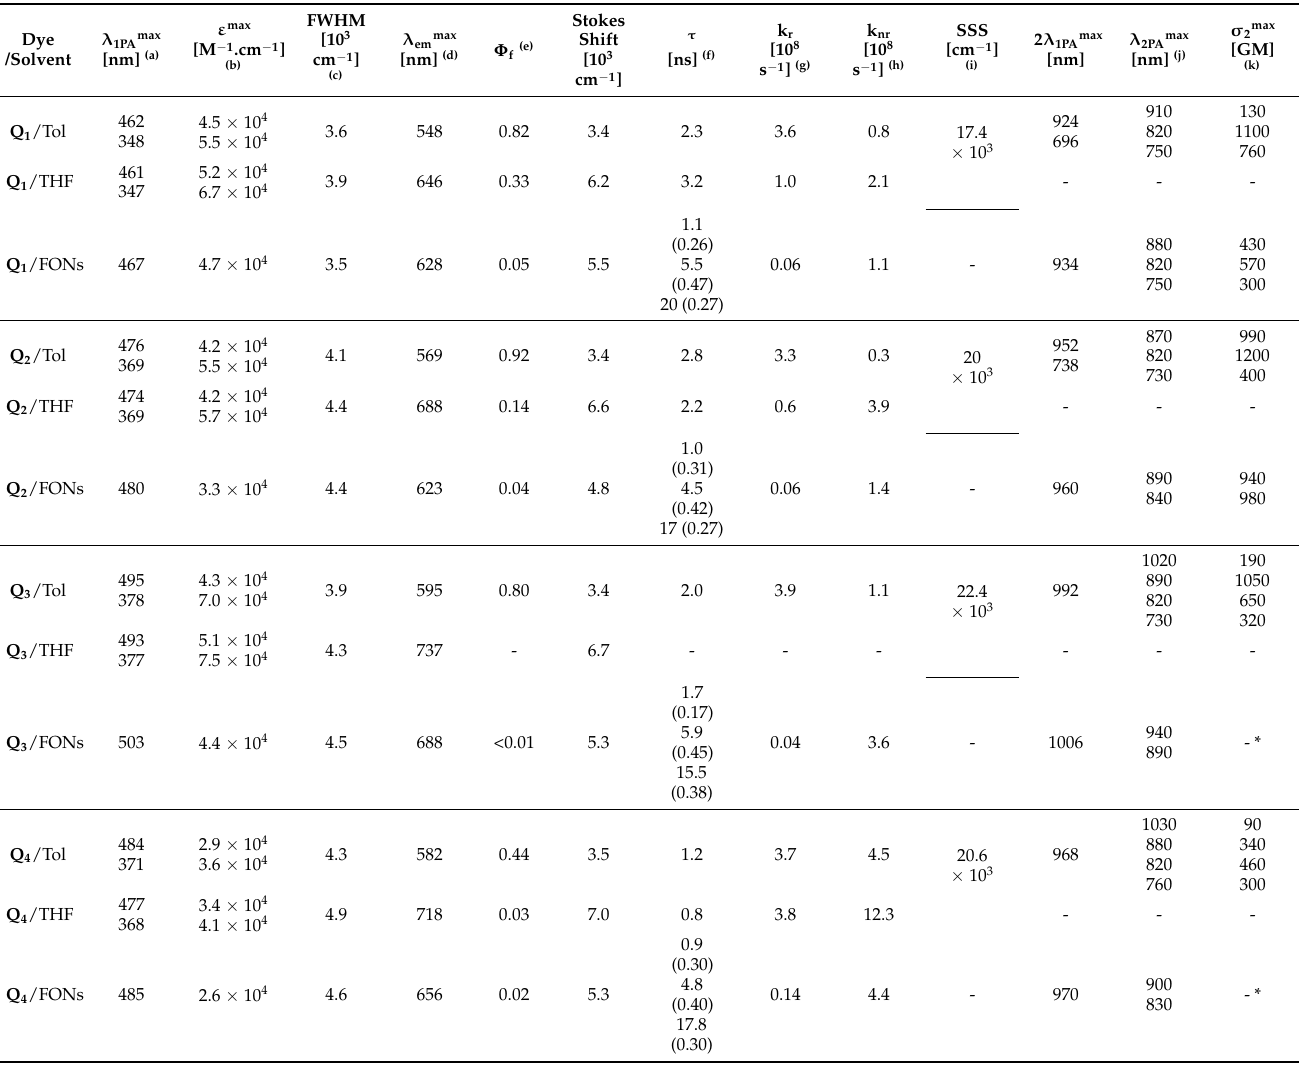
Table 1. 1P and 2P photophysical data of dyes Q 1 – Q 4 in toluene and